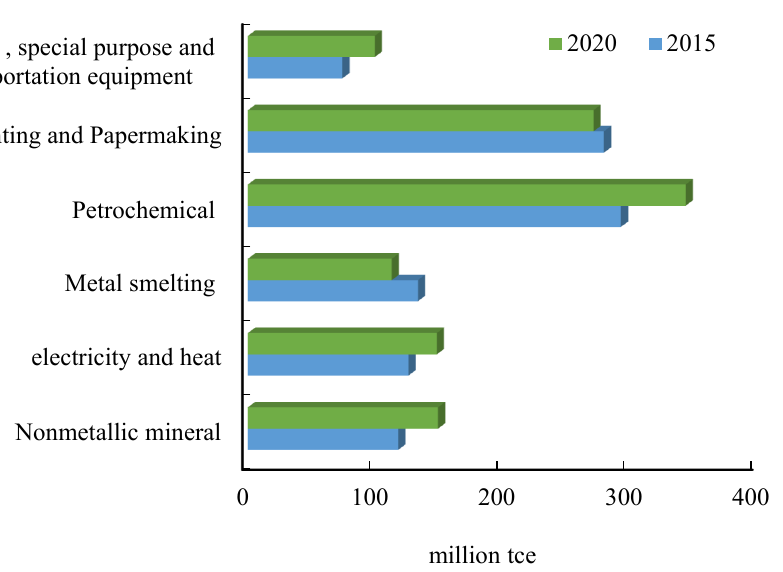
Figure 1. Energy consumption by industry in Zhejiang Province (2015, 2020). Data source: CEIC and author.